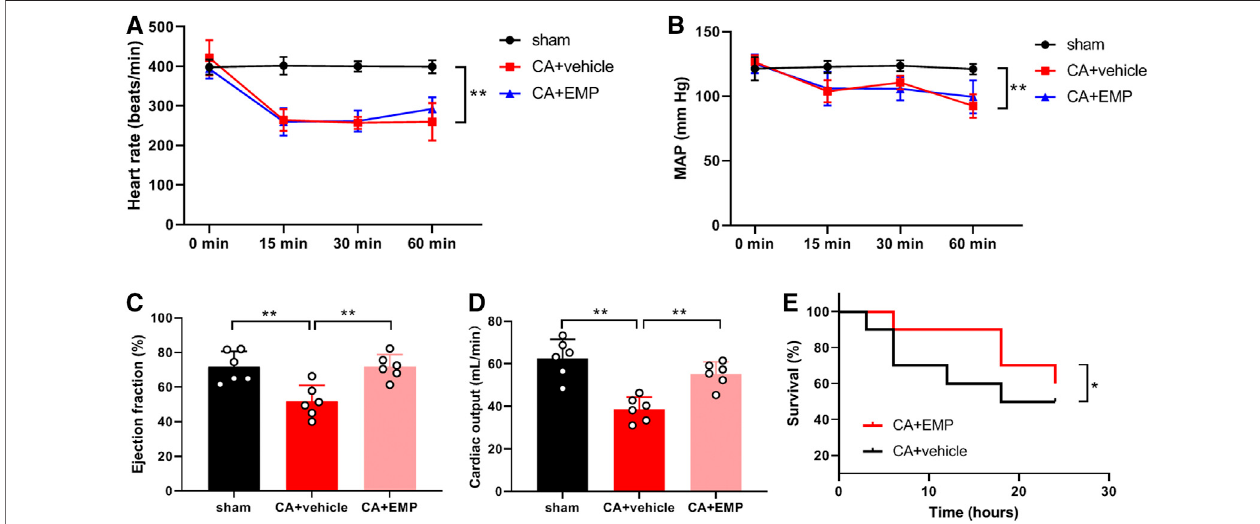
FIGURE 2 | Empagli fl ozin (EMP) improved cardiac function after cardiac arrest in rats. (A) Effect of EMP on heart rate within 1 h after return of spontaneous circulation (ROSC) ( n (cid:1) 7 – 10). (B) Effect of EMP on mean artery pressure (MAP) within 1 h after ROSC ( n (cid:1) 7 – 10). (C) EMP increased left ventricular ejection fraction at 24 hafterROSC ( n (cid:1) 6). (D) EMPincreasedcardiac outputat 24 hafterROSC( n (cid:1) 6). (E) EMPimprovedsurvivaloftheratsafter cardiac arrestwithin24 h( n (cid:1) 10).Data are presented as mean ± SD, * p < 0.05, ** p < 0.01.